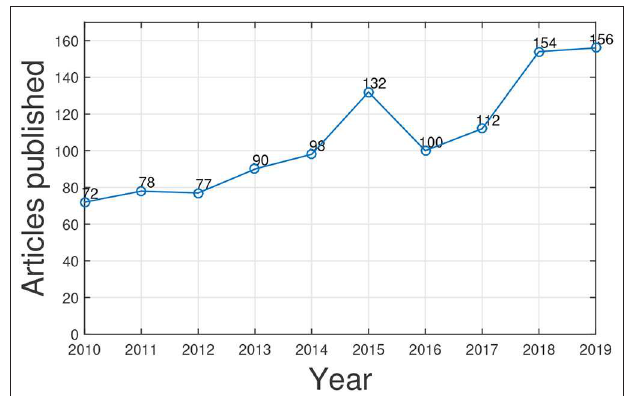
FIGURE 2 | The number of published papers related to GO-based gene function prediction over 10